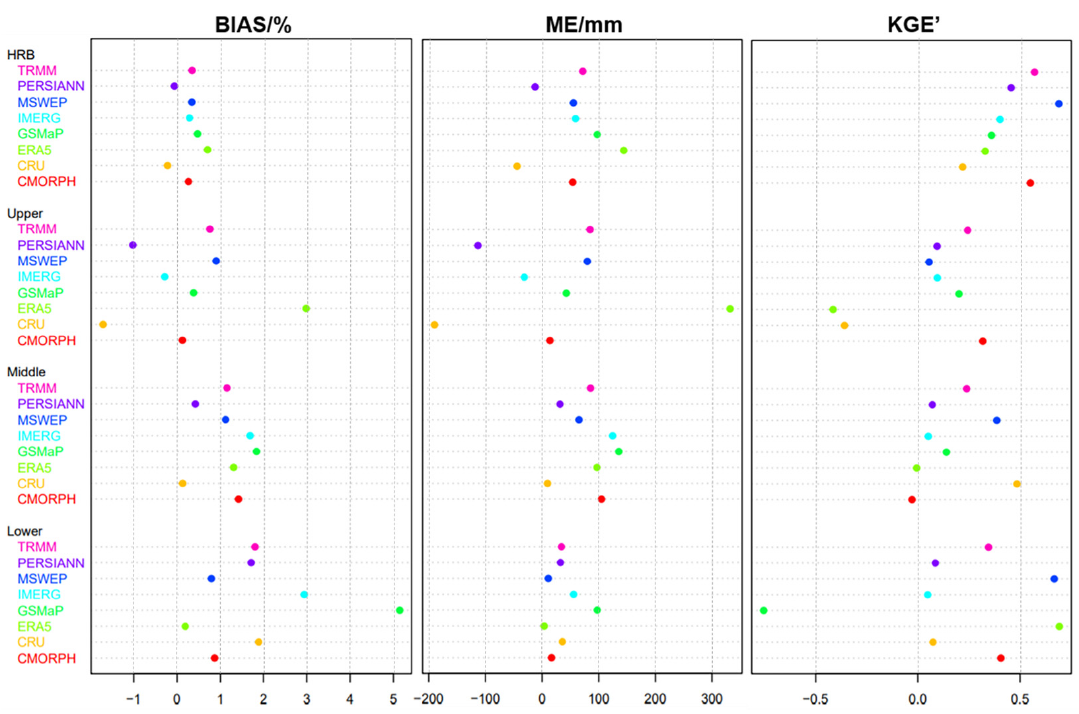
Figure 4. Dot plots of three indices of annual precipitation from each product over the HRB and its upper, middle and lower reaches during 2016–2019.